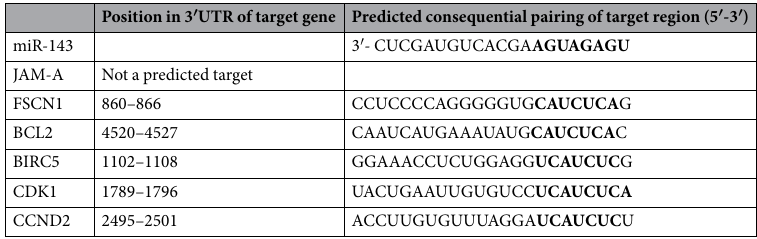
Table 1. Predicted Target Genes of miR-143.